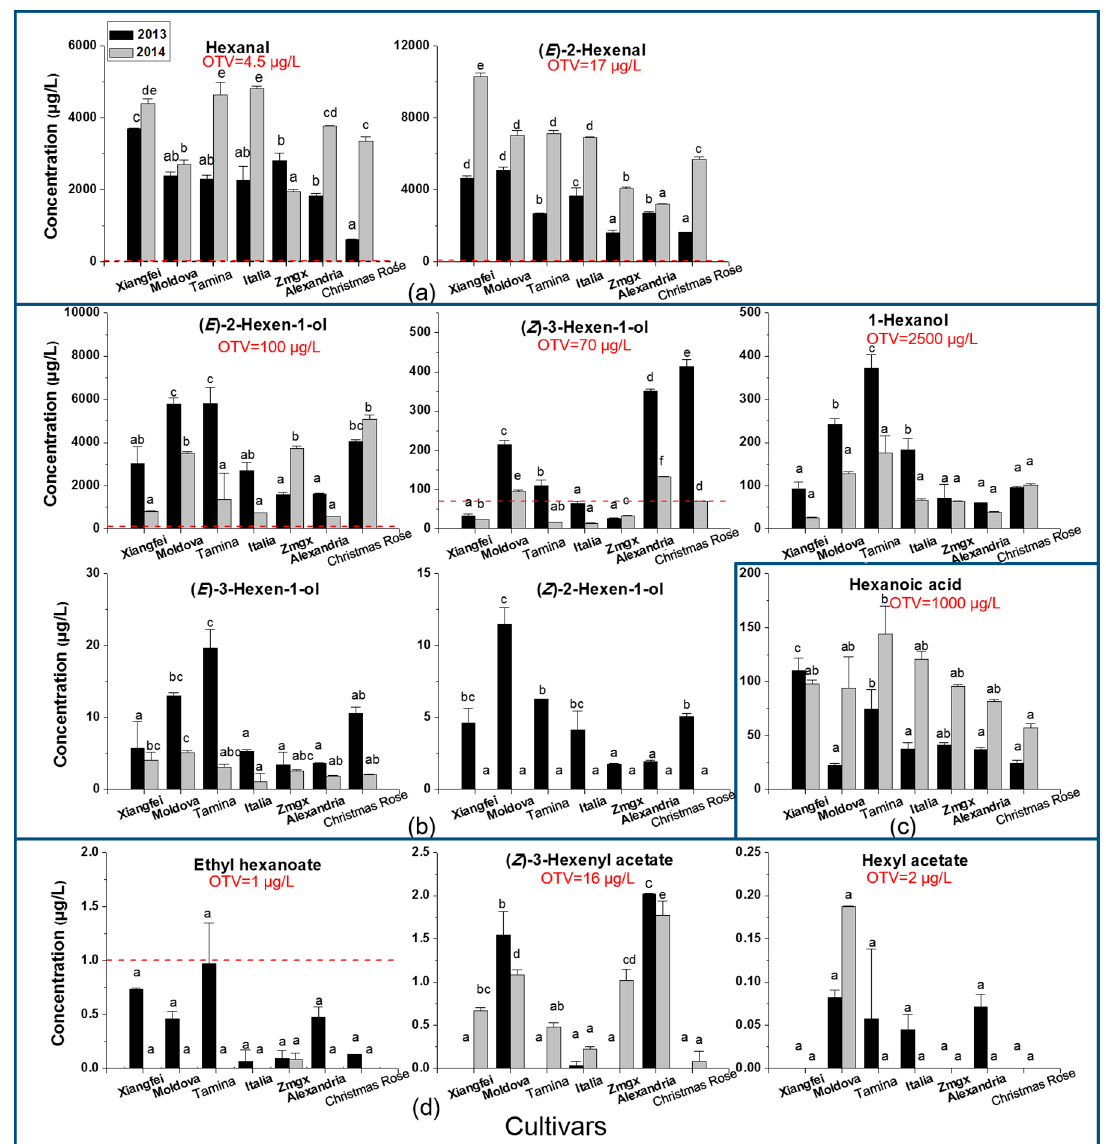
Figure 1. Concentrations of volatile compounds and their odor threshold values in different table grape cultivars at harvest. ( a ) C6 aldehydes; ( b ) C6 alcohols; ( c ) C6 acid; and ( d ) C6 esters. Different letters mean significant differences according to the Duncan test ( p < 0.05) in individual vintages. “Zmgx” represents the “Zaomeiguixiang” cultivar; “Alexandria” represents the “Muscat of Alexandria” cultivar; OTV is the odor threshold value.